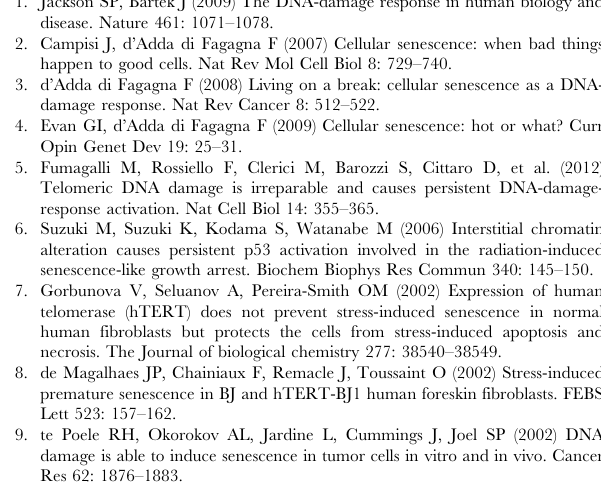
Figure S5 DDR foci distribution in BJ and WI-38 before and at different time points after senescence establish- ment. Histograms show the distribution of c H2AX foci for data in Fig. 3a. (PPTX) Figure S6 Both senescent WI-38 and BJ cells can mount a proficient DDR upon acute DNA damage. WI-38 senescent cells (WI-38 sen) are still able to mount a DDR as detected in the form of c H2AX foci 1 day after induction of DNA damage by irradiation with 20 Gy, similarly to BJ senescent cells (BJ sen). Scale bar, 5 m m. (PPTX) Figure S7 BJ and IMR-90 activate a comparable DDR initially upon irradiation. BJ and IMR-90 cells were irradiated with 1 Gy and stained 10 minutes later. a. Represen- tative images of 53BP1 foci. Scale bar, 20 m m. b. Quantification of number of 53BP1 foci per cell. (PPTX) Figure S8 Differential kinetics of DDR foci resolution in different cell types. Representative pictures of 53BP1 foci in BJ and IMR-90 at the indicated time points after 20 Gy irradiation. Scale bar, 20 m m. (PPTX) Figure S9 DDR foci distribution in BJ and IMR-90 at different time points following irradiation. Histograms show the distribution of 53BP1 foci for data in Fig. 4b.